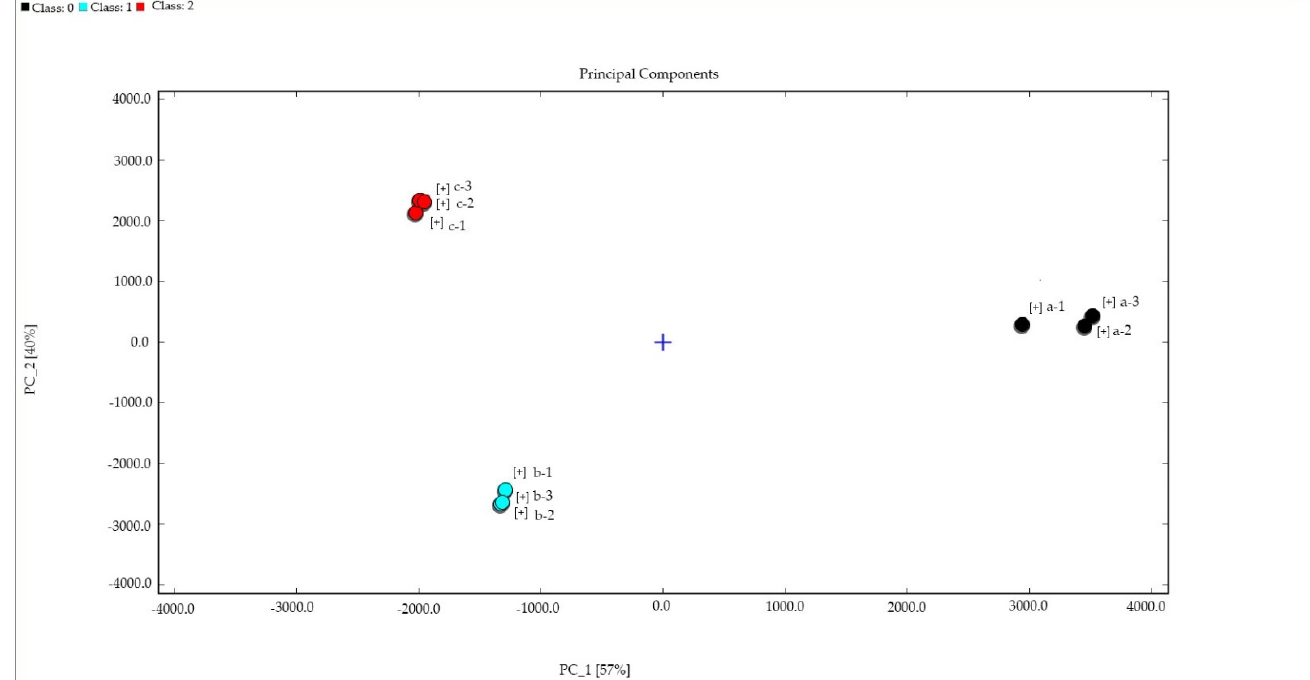
Figure 5. PCA of different samples. a: Oil cistanche, b: blood cistanche, c: cistanche tubulosa in Xin- jiang.